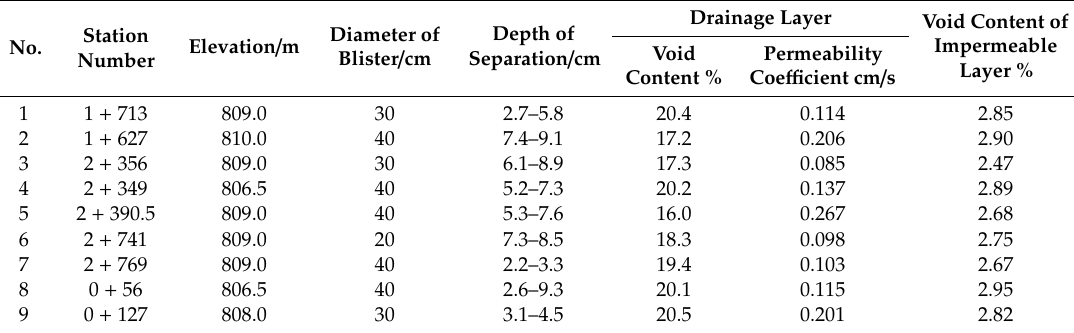
Table 2. Test results of additional